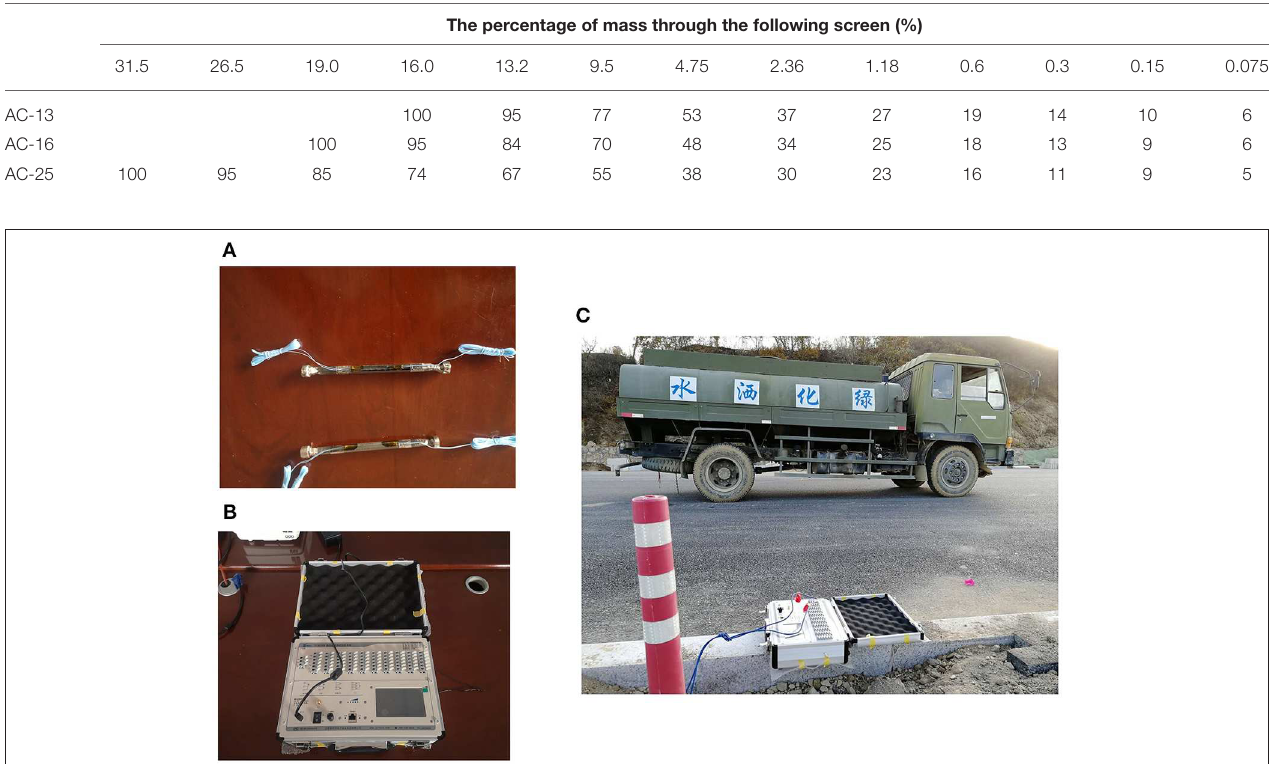
FIGURE 1 | (A) Two strain sensors, (B) strain collecting instrument, and (C) pictures of field tests.